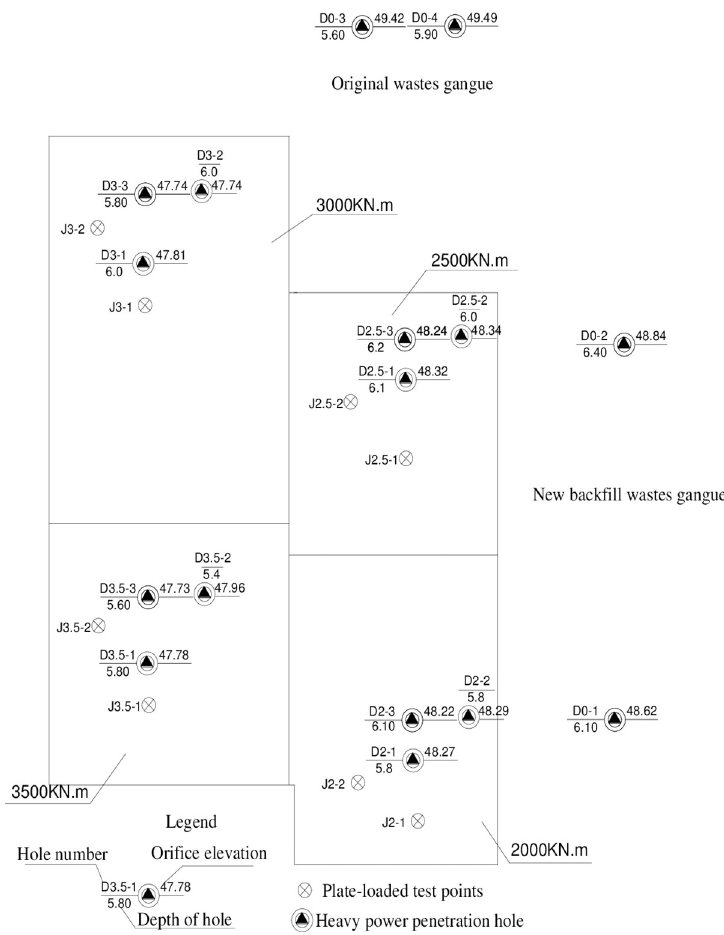
Fig 14. Layout of test points for the static load loading test and heavy dynamic penetration